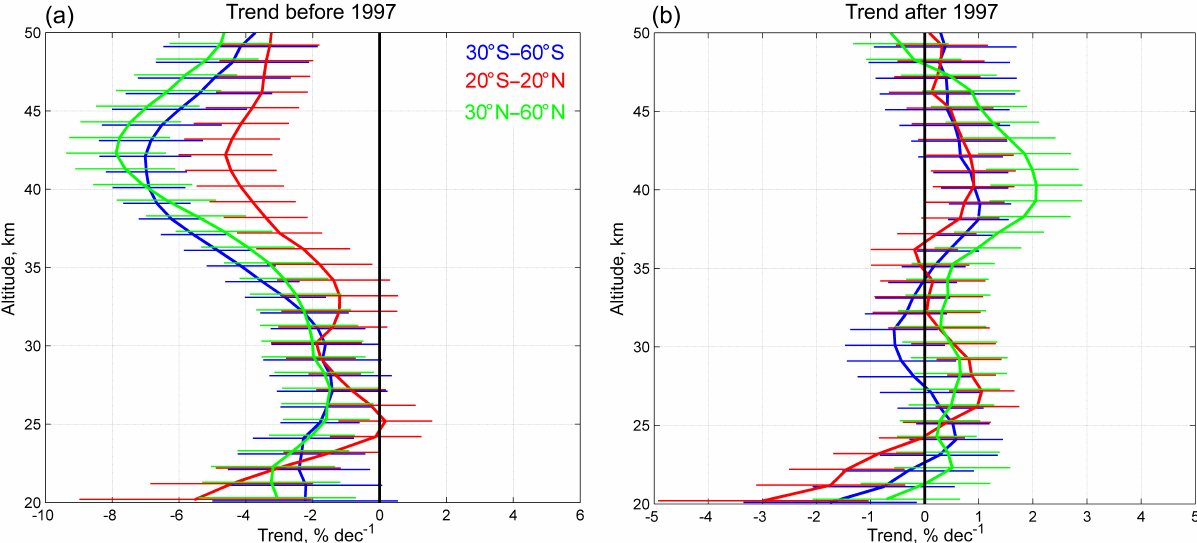
Figure 11. Vertical profiles of ozone trends obtained by the multiple regression Eq. (9), in 1984–1997 (a) and in 1998–2016 (b) , for broad latitude bands. Error bars are 2 σ